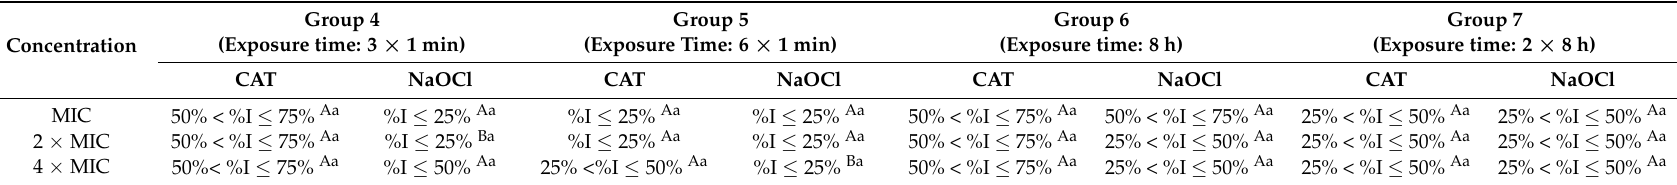
Table 5. Percentage of inhibition (%I) of preformed biofilms of Candida albicans ATCC 60193 treated with chloramine T (CAT) or sodium hypochlorite (NaOCl) with different exposure